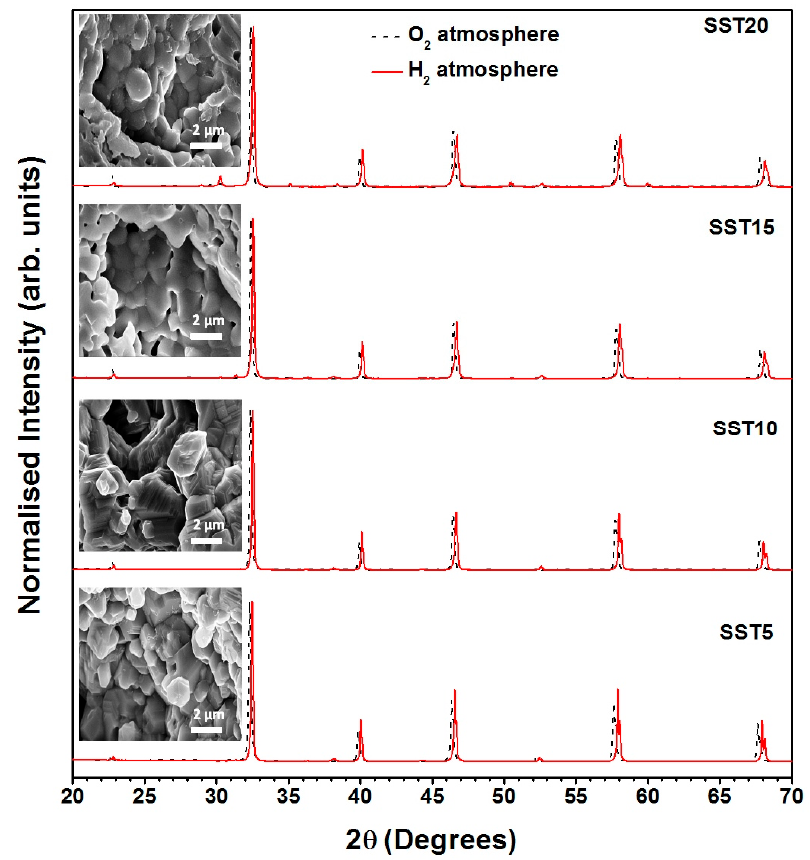
Figure 9. XRD patterns of unreduced and reduced samples and inset FESEM micrographs of reduced compositions.